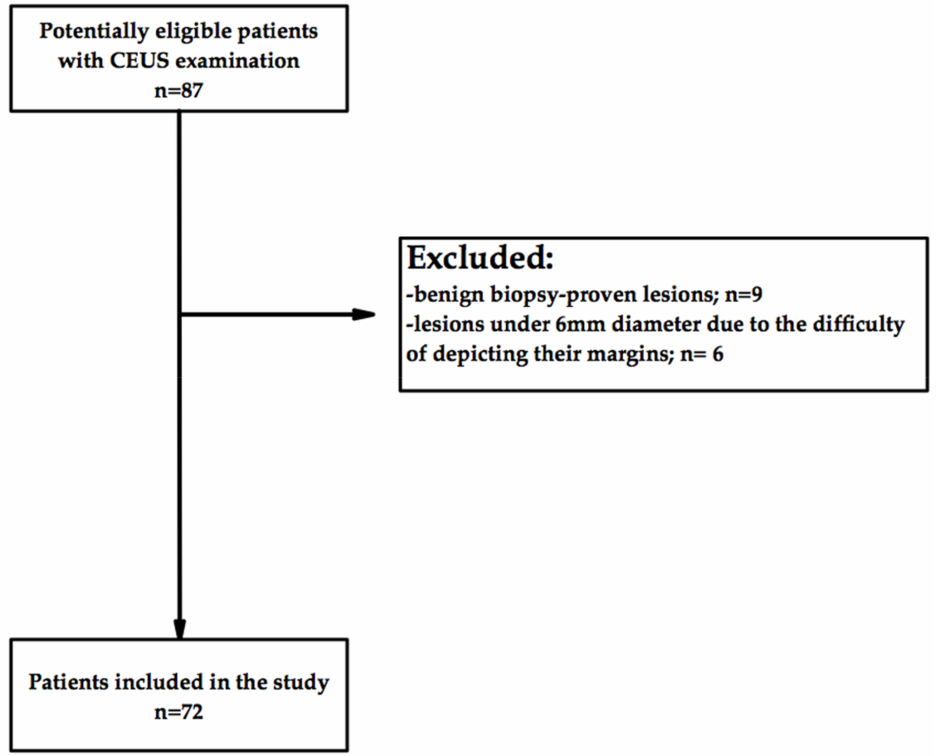
Figure 1. Flowchart of patient inclusion in the